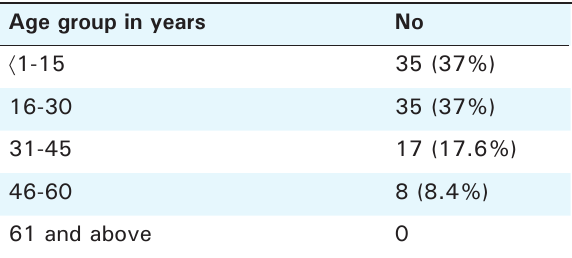
Table 6. Age distribution of patients on Valproic acid (n=95*) Age group in